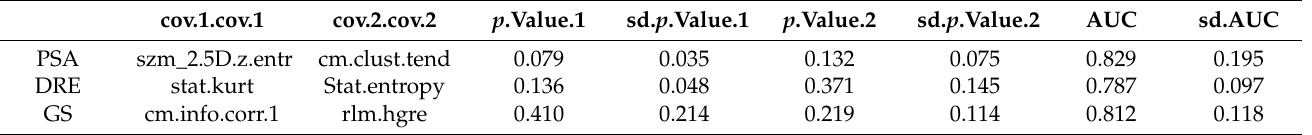
Table 3. Bivariate analysis among considered clinical outcomes, i.e., PSA, digital rectal examination, and Gleason Score and most relevant radiomic features at univariate